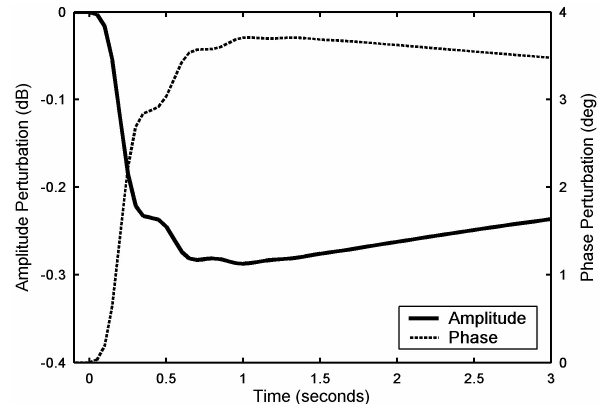
Fig. 8. Calculated onset of VLF perturbation due to the WEP pulse train shown in Fig.